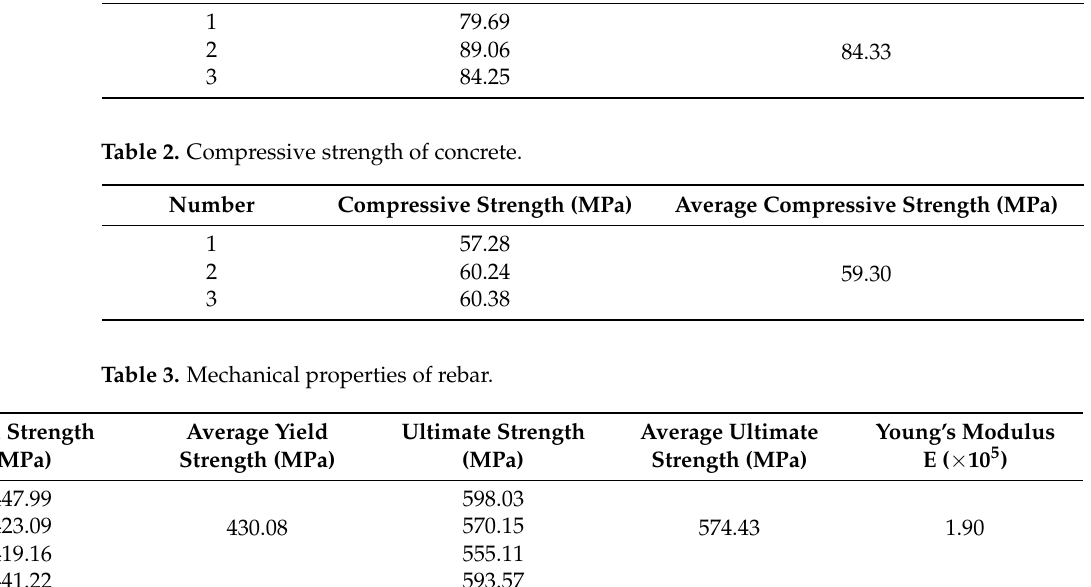
Table 1. Compressive strength of high-strength grouted mortar.